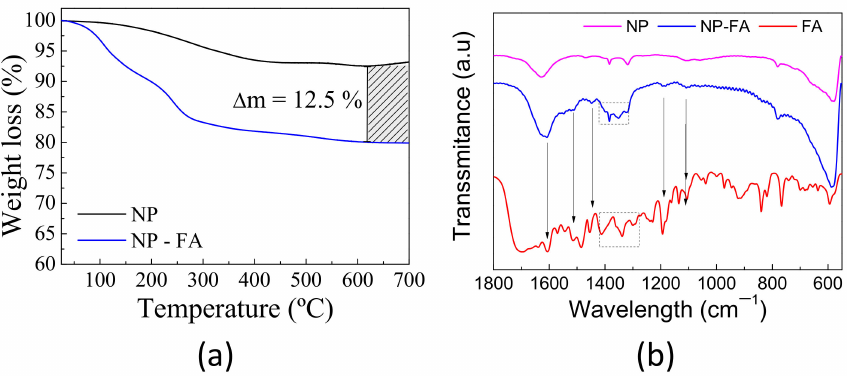
Figure 1. ( a ) Thermogravimetric analysis of bare nanoparticles (NP) (black line) and nanoparticle- folic acid (NP-FA) (blue line) under air conditions. The striped square is a guide for eyes to highlight the difference in weight loss between samples. ( b ) FTIR spectrum of bare NPs, NPs functionalized with folic acid, and the FA